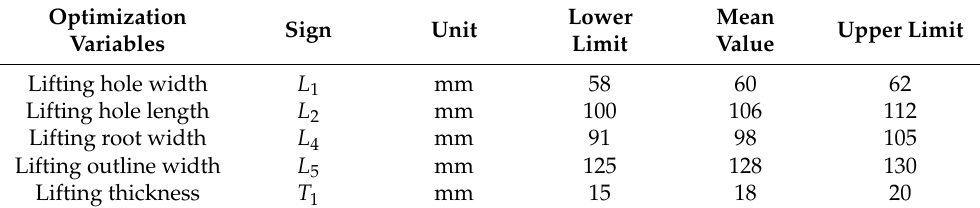
Table 5. Numerical characteristics of the optimization variables.